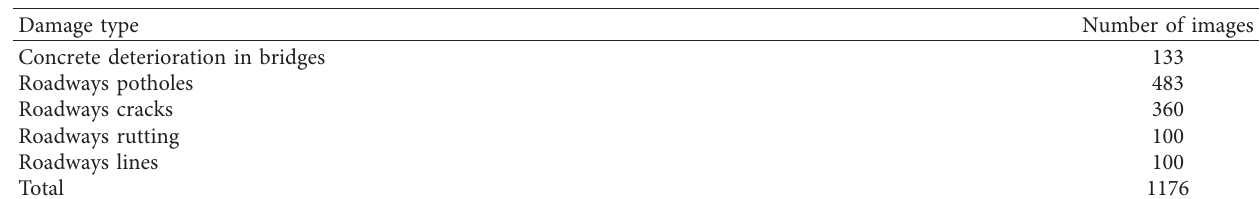
Table 2: Dataset